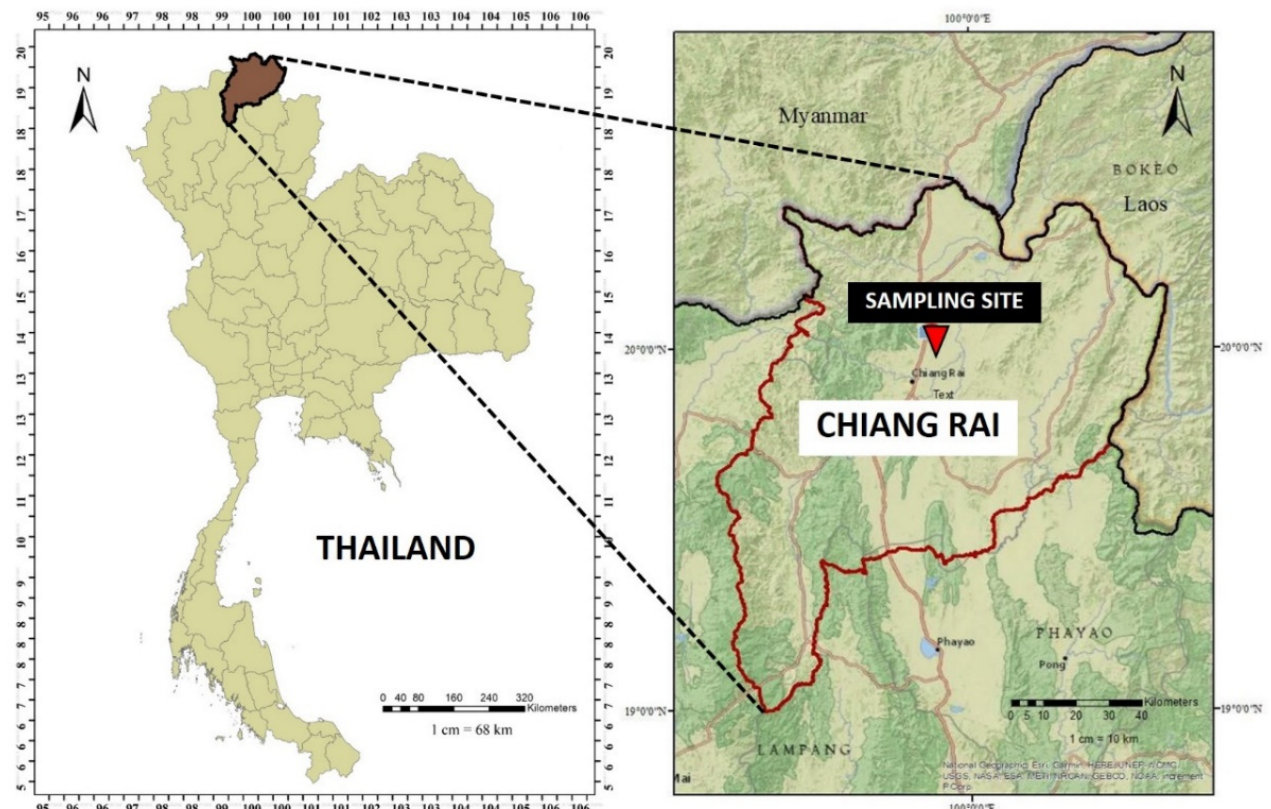
Figure 1. Location of sampling site in Chiang Rai, Thailand .